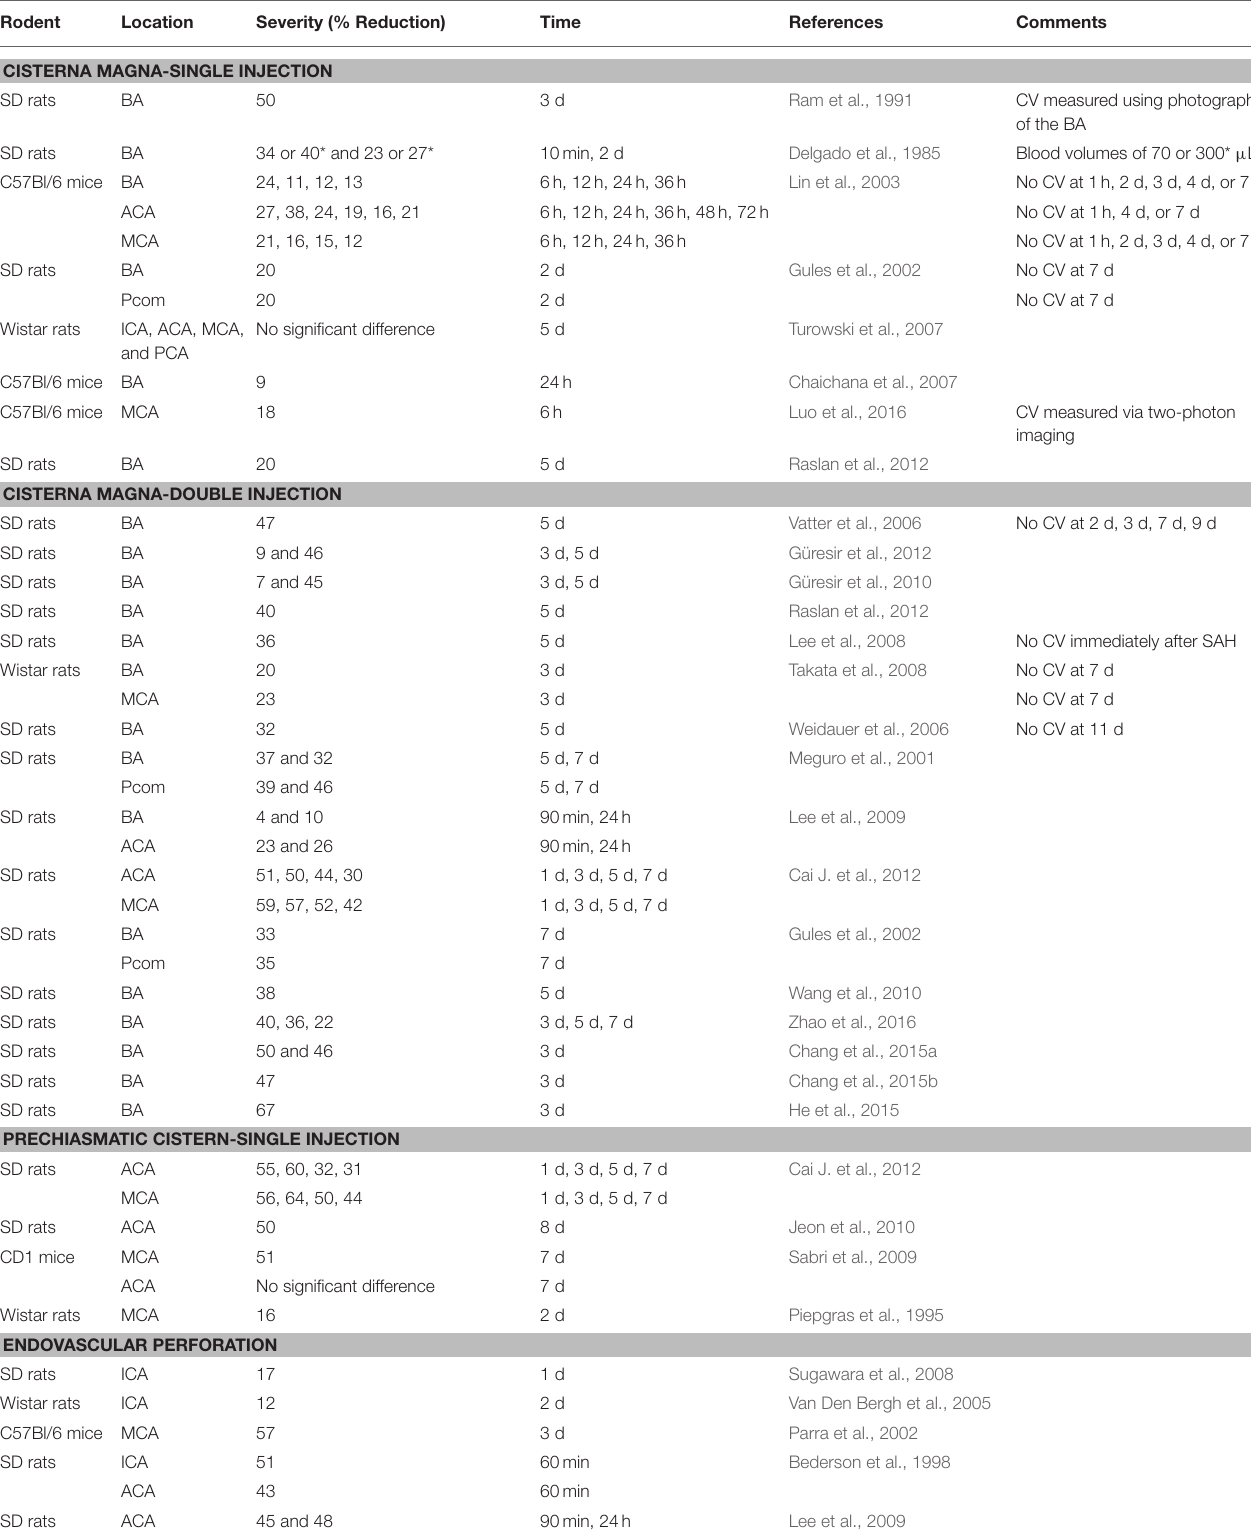
TABLE 4 | Summary of cerebral vasospasm itemized by the model used for SAH induction in published studies that used various strains of mice or rats. Rodent